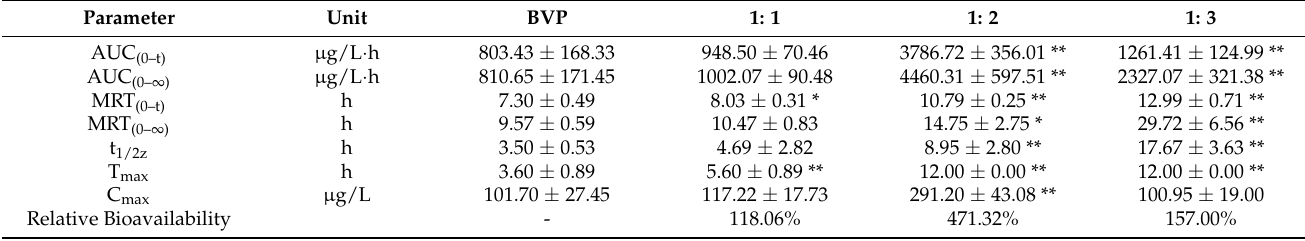
Table 4. Pharmacokinetics parameters of BVP and BVP-PLC with different drug-lipid ratios (equivalent to BVP 20 mg/kg).